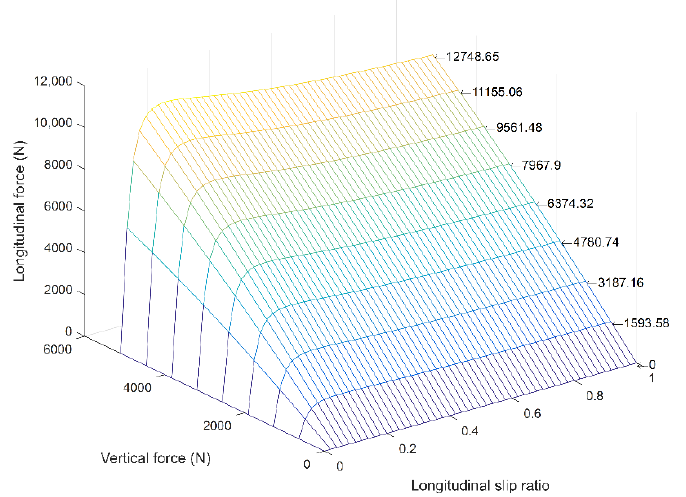
Figure 6. Three-dimensional map of longitudinal force corresponding to vertical force and slip